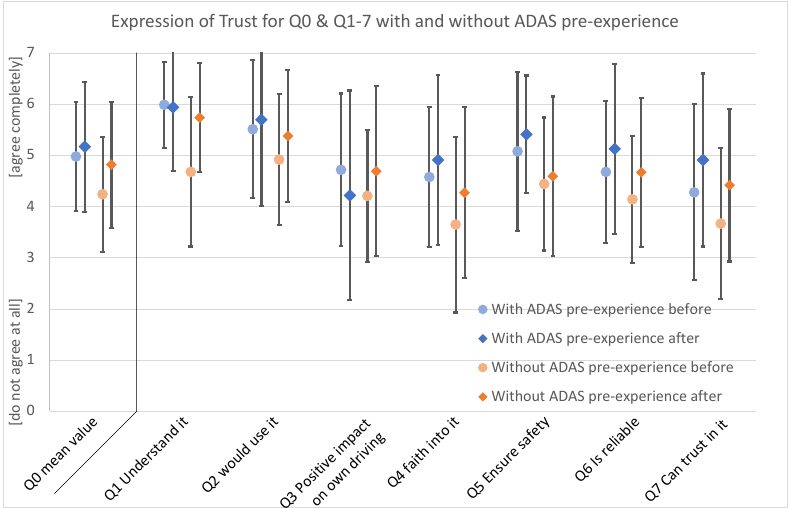
Figure 5. Expression of trust for question 0 (Q0—mean value) and detailed question 1–7 (Q1–7) with and without ADAS pre-experience, before and after the test. Table 1. Mean values (m), standard deviation (sd) and ANOVA-results for ADAS pre-experience x